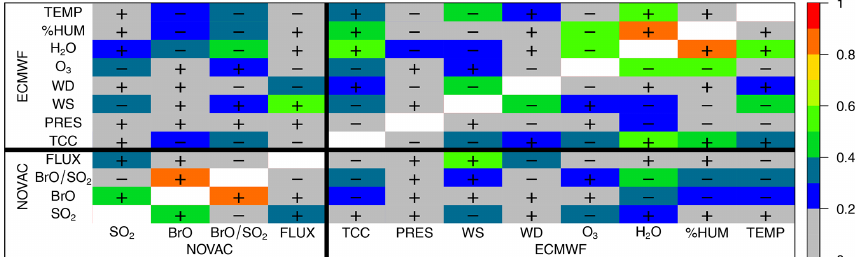
Figure 12. Correlation matrix between the different NOVAC parameters and the original ECMWF ERA-Interim parameters. The colour bar indicates the absolute value of the correlation coefficient and the plus and minus signs indicate the sign of the correlation coefficient. The abbreviated parameters are, from left to right, daily means of SO 2 dSCDs, BrO dSCDs, BrO / SO 2 molar ratios, and SO 2 emission fluxes and noon-time time series of total cloud cover, pressure, wind speed, wind direction, ozone mixing ratio, water vapour concentration, relative humidity, and ambient temperature. The auto-correlation pixels are removed for better